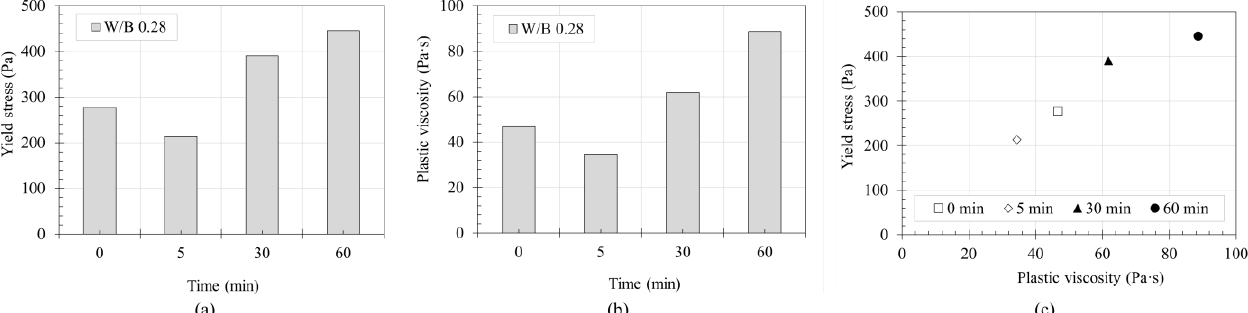
Figure 8. Evaluated rheological properties depending on time: ( a ) yield stress; ( b ) plastic viscosity; ( c ) relationship between plastic viscosity and yield stress.